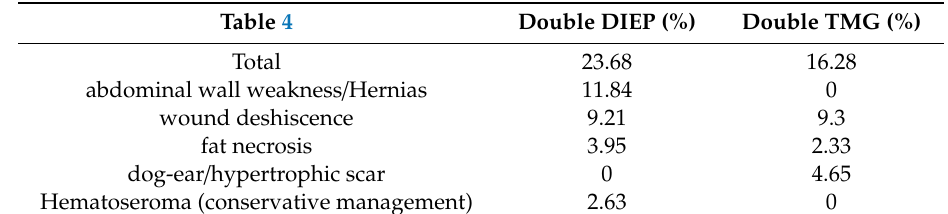
Table 4. Donor site morbidity in detail.